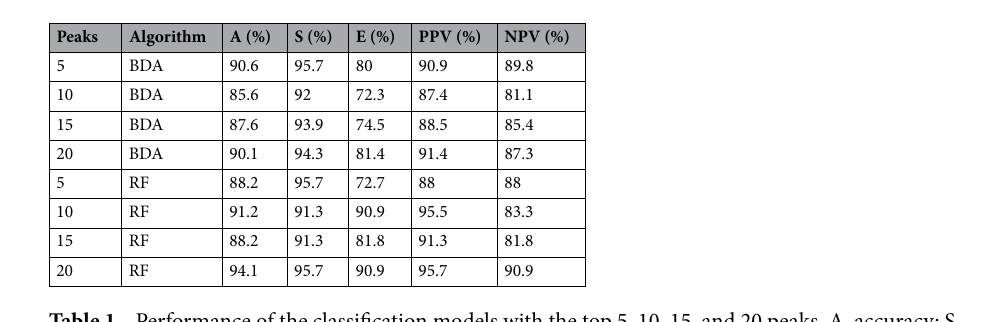
Table 1. Performance of the classification models with the top 5, 10, 15, and 20 peaks. A, accuracy; S, sensitivity; E, specificity; PPV, positive predictive value; NPV, negative predictive value.